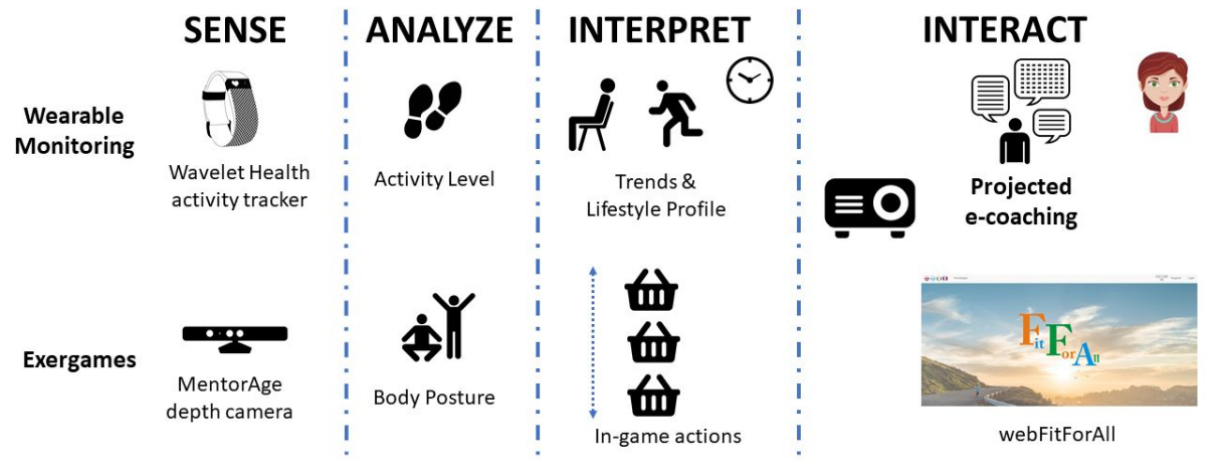
Figure 1. Protocol phases and technology introduced in each